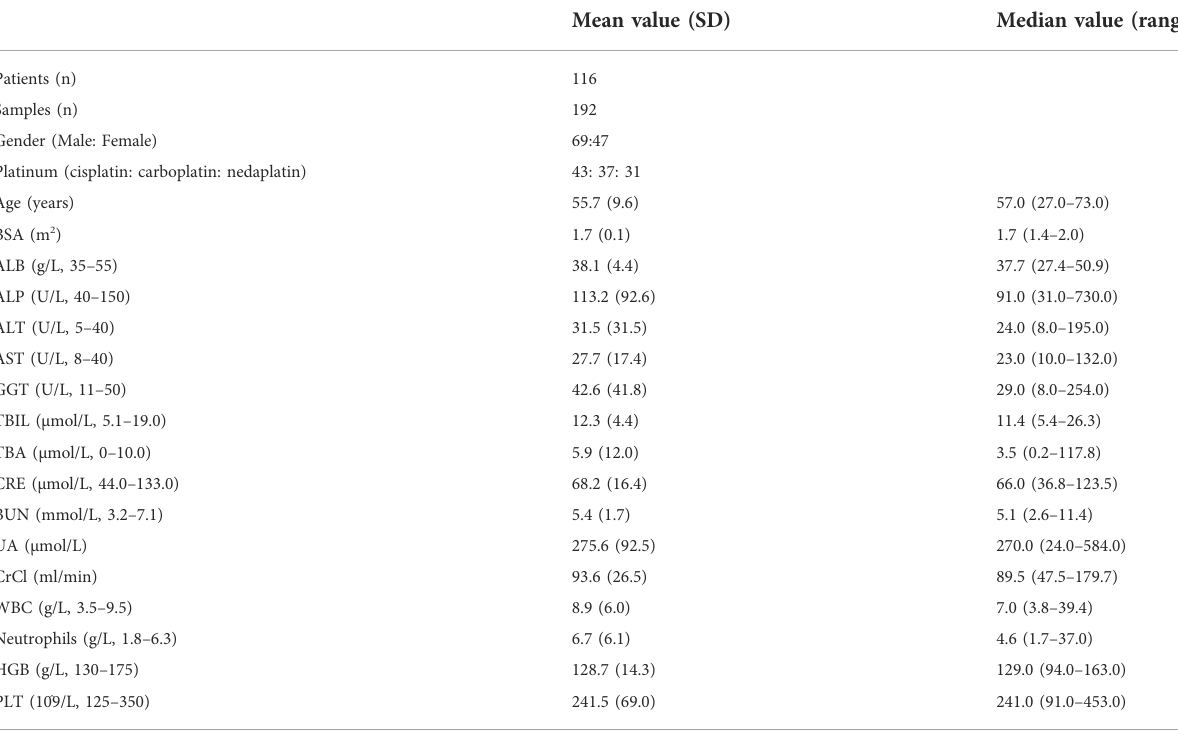
TABLE 1 Clinical characteristics of 116 NSCLC